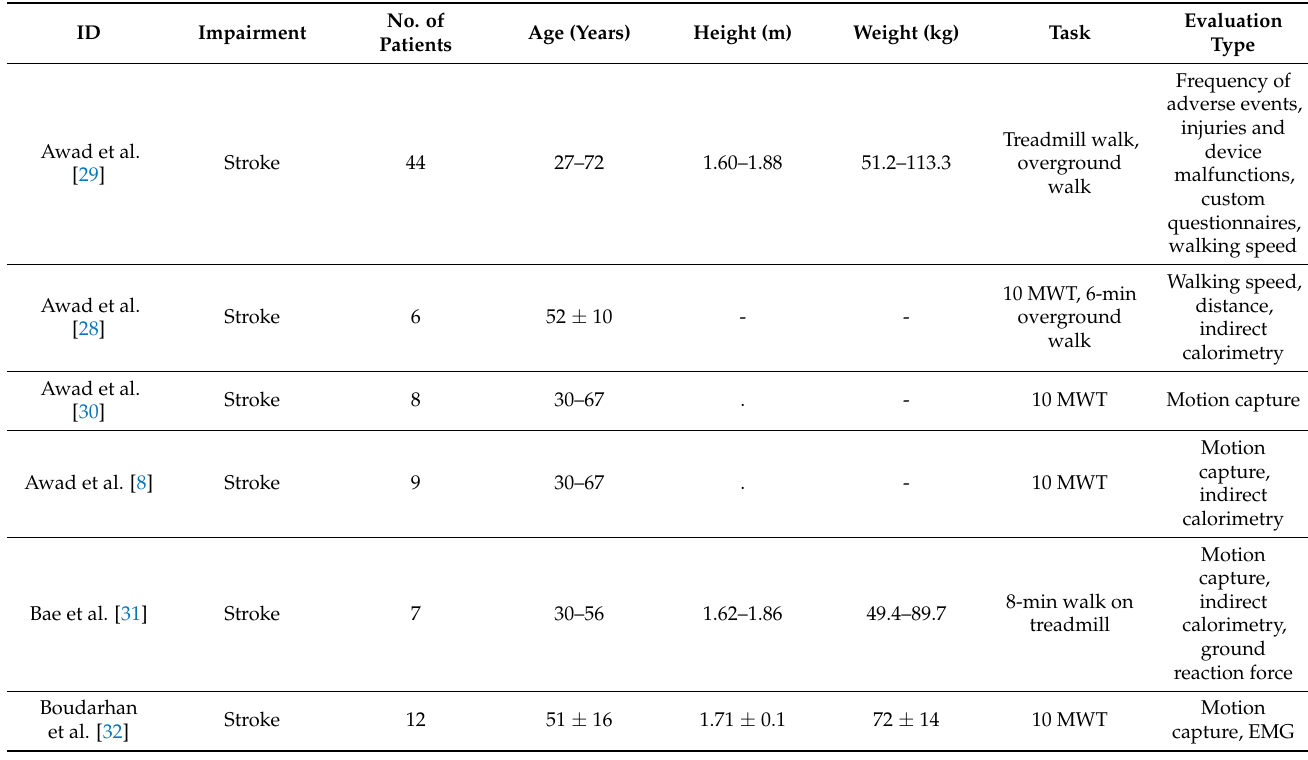
Table 4. Clinical data extracted from the relevant